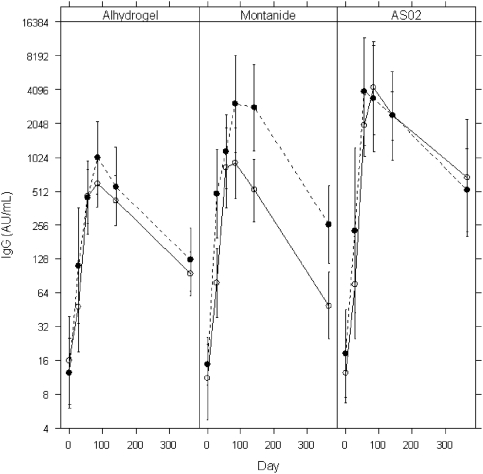
Mean log anti-AMA-1 titers with standard error of the mean for low and high dose per adjuvant group.Anti-AMA-1 titers were determined by ELISA for the six different groups, immunized with Alhydrogel™, Montanide and AS02 adjuvanted PfAMA1 vaccine. Dashed lines represent high dose of PfAMA1 (50 µg), continuous lines represent low dose groups (10 µg). Measurements were performed at baseline, 28 days after the first, second and third immunisation (day 28, 56 and 84 respectively) and day 140 and 365.